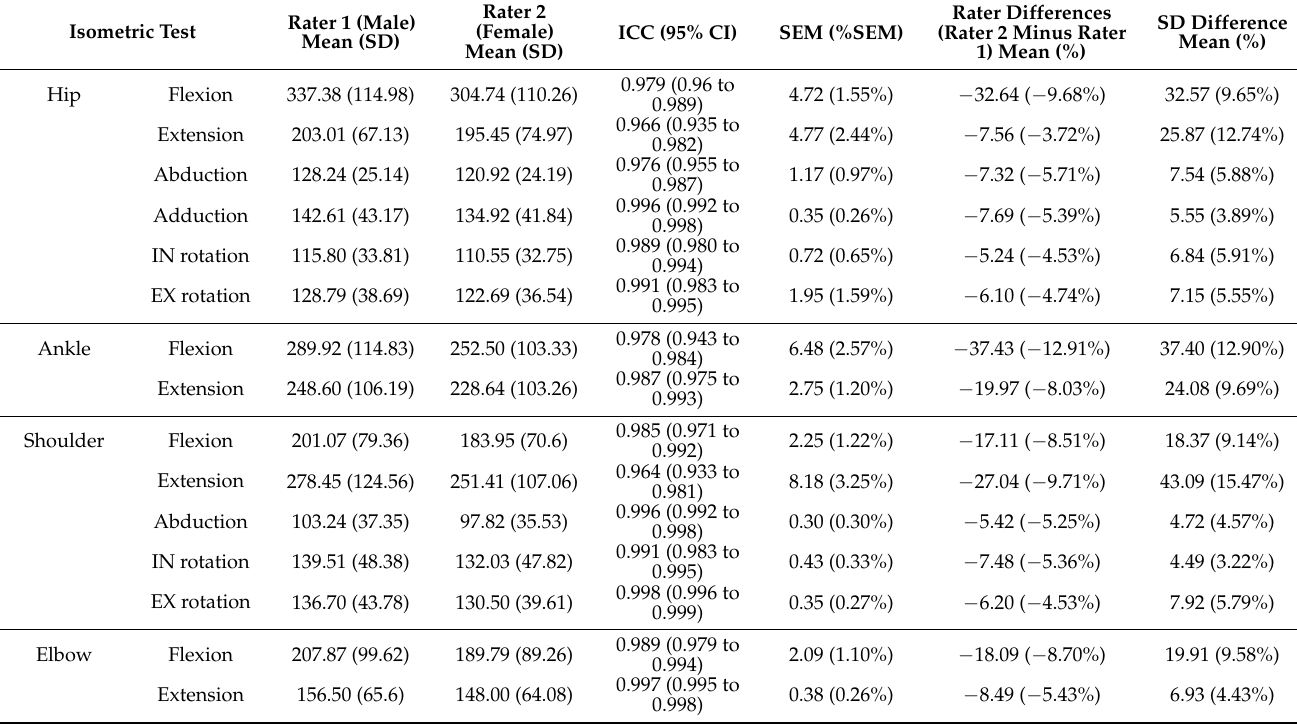
Table 4. Inter-rater reliability and agreement for the push HHD method by